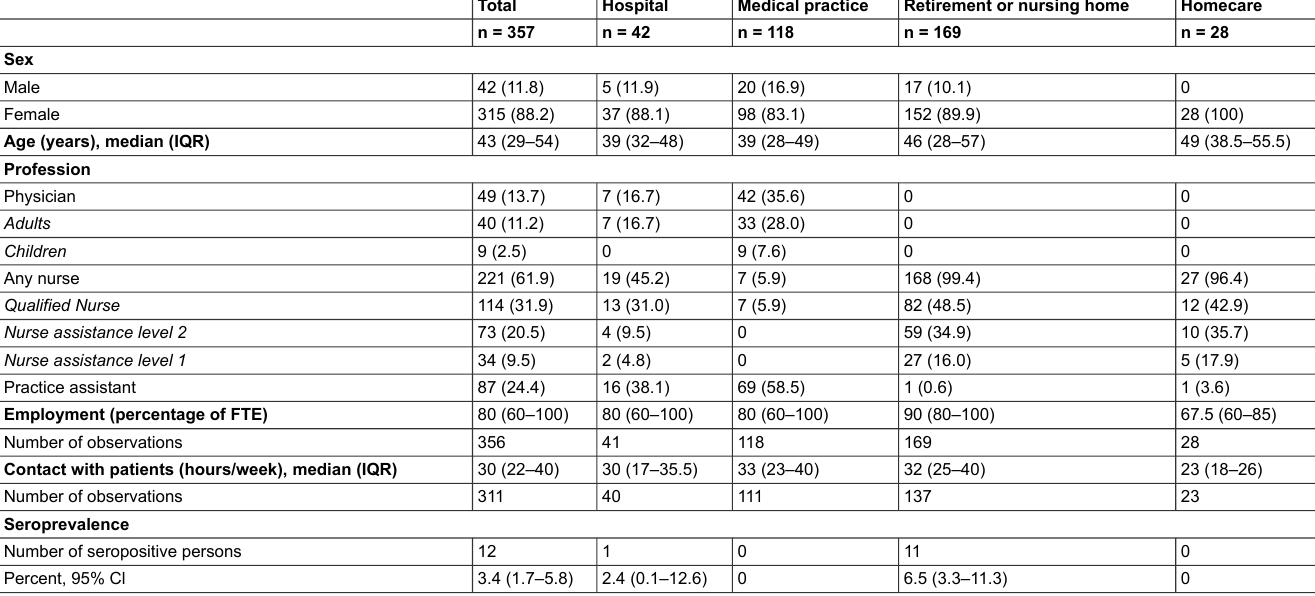
Table S2: Characteristics by healthcare facility (n =